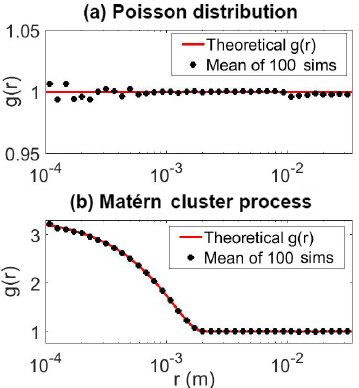
Figure 5. Verification that the effective volume method for calculat- ing g(r) as described in the main text works for non-cubical sample volumes with realistic aspect ratios. In panel (a) , 100 different sim- ulations of a Poisson distribution (perfect spatial randomness) were created by placing 10000 particles within a sample volume with the same dimensions as the HOLODEC sample volume. The mean of the 100 simulations agrees very well with the theoretical g(r) = 1 curve. An unrealistically large number of particles were used for each simulation in order to minimize the sampling concerns. Note that though the agreement is very good, the most pronounced de- viations from the theoretical curve still occur as expected at small spatial scales. In panel (b) , 100 different simulations of a Matérn cluster process were generated and compared to the known theoret- ical expression (see, e.g., Larsen et al., 2014). Clearly, agreement between the mean of the simulations and the theoretical curve is excellent.